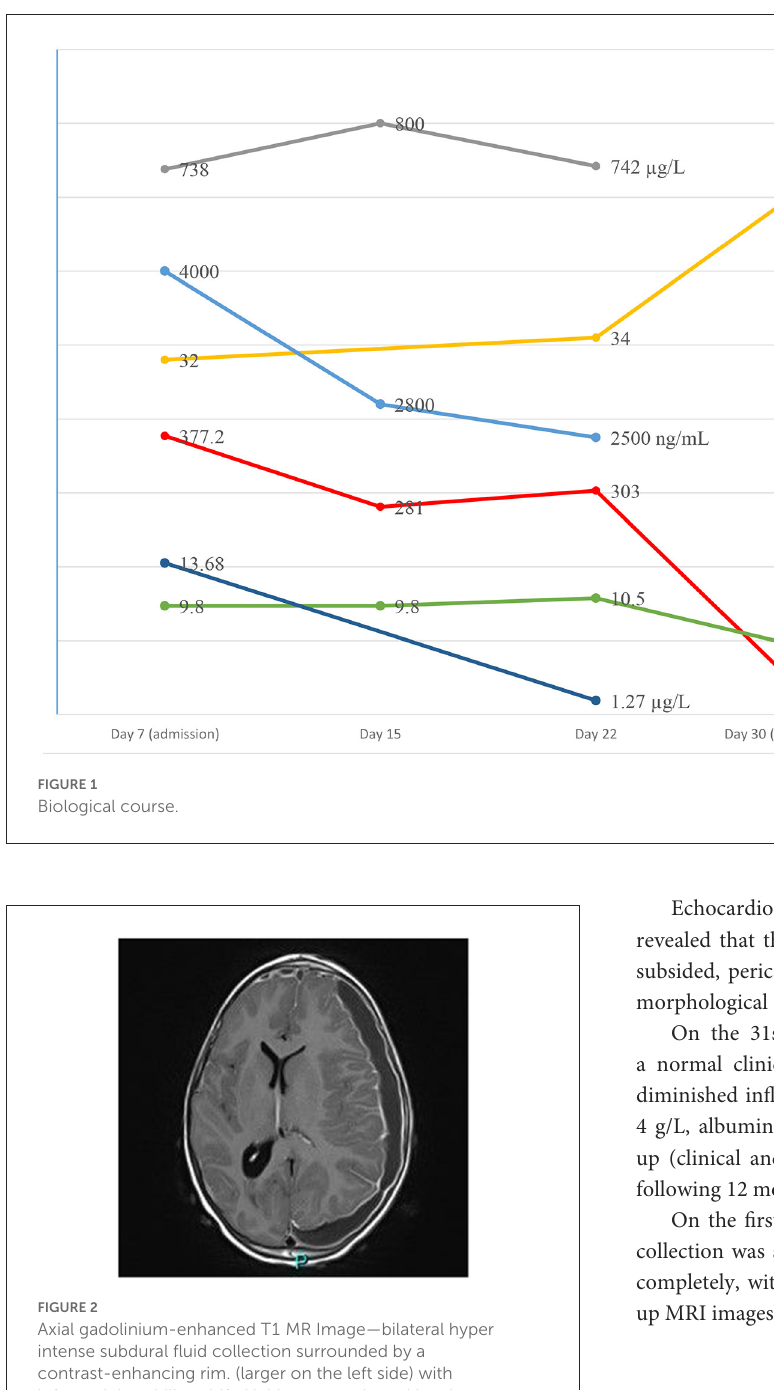
of inflammatory origin. Despite the lack of any viral and bacterial illnesses, empirical antibiotic (amoxicillin/clavulanic acid) treatment was